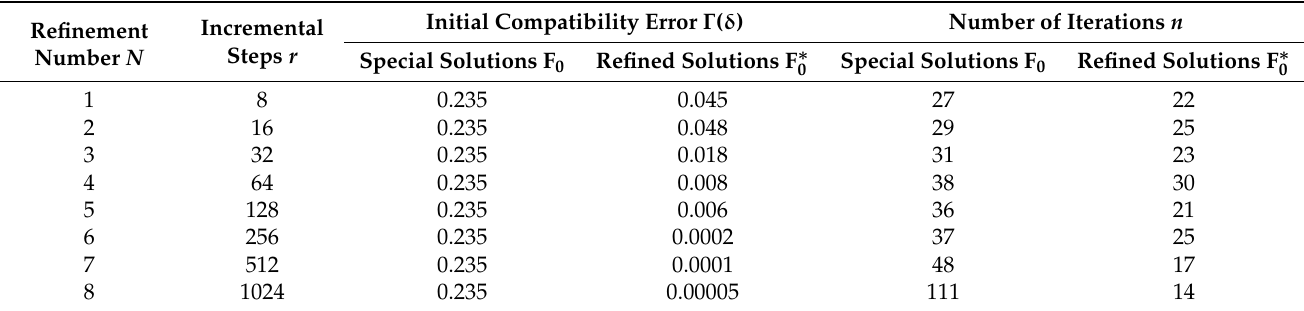
Table 2. Comparison of results using different initial generalized internal